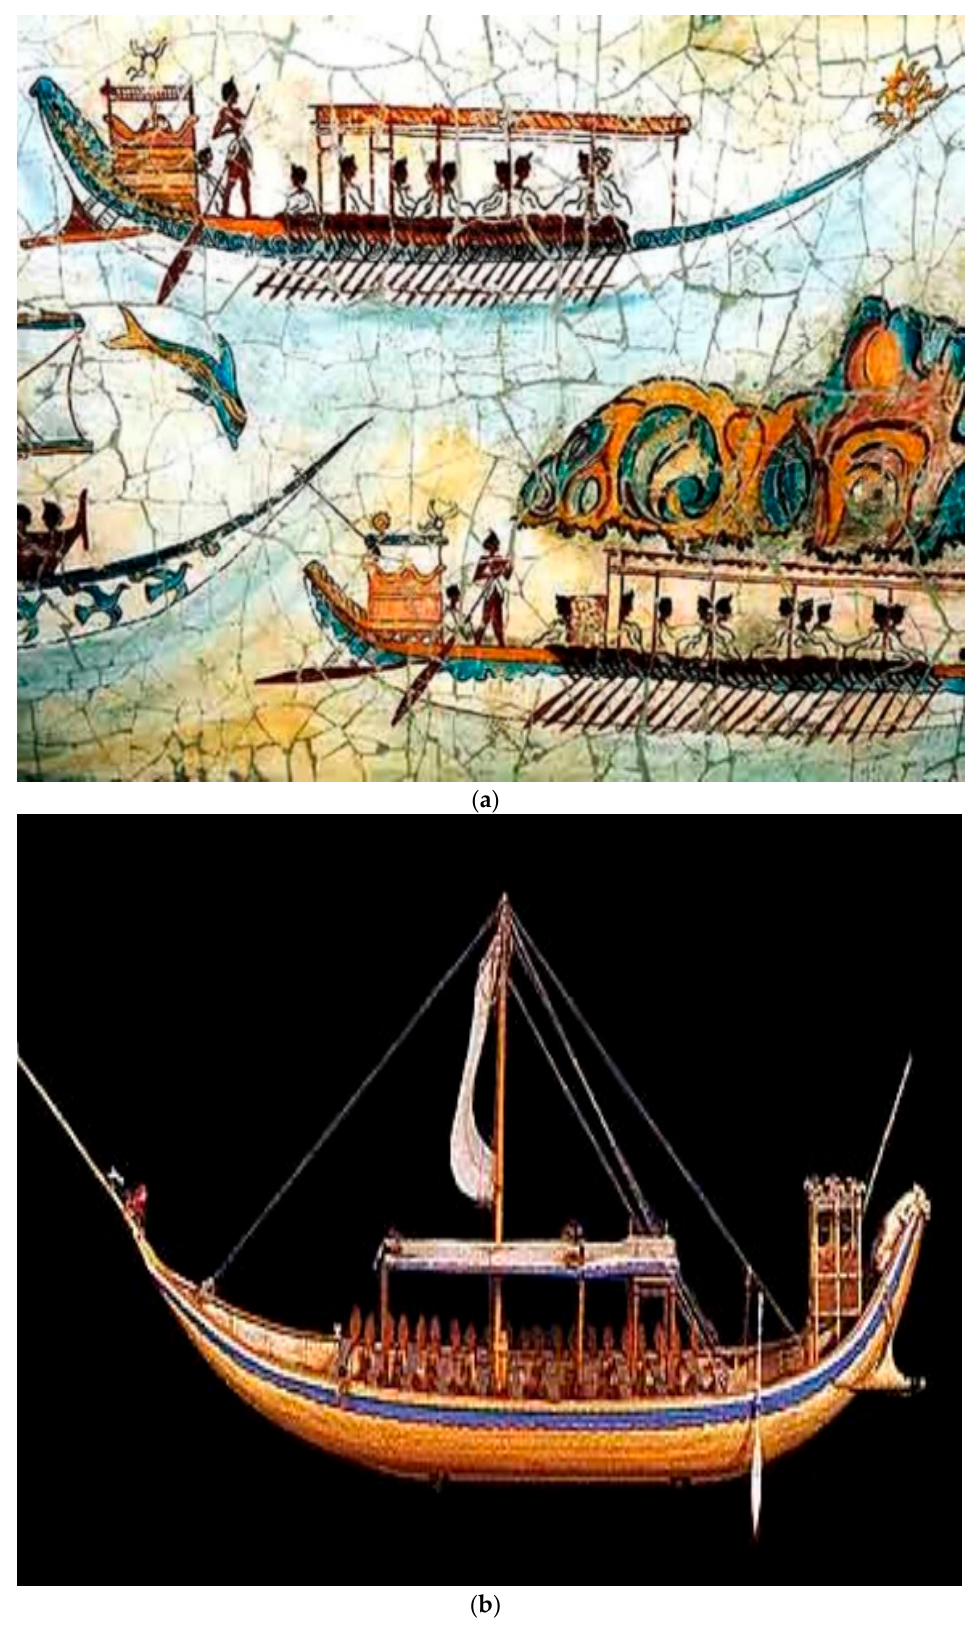
Figure 2. Examples of Minoan ships: ( a ) paintings of Minoan ships, as parts of Fresco in “Akrotiri”, Thera [25] and ( b ) a potential model of a ship adapted from the Theran Fresco that further provided insights of the reconstruction [26].